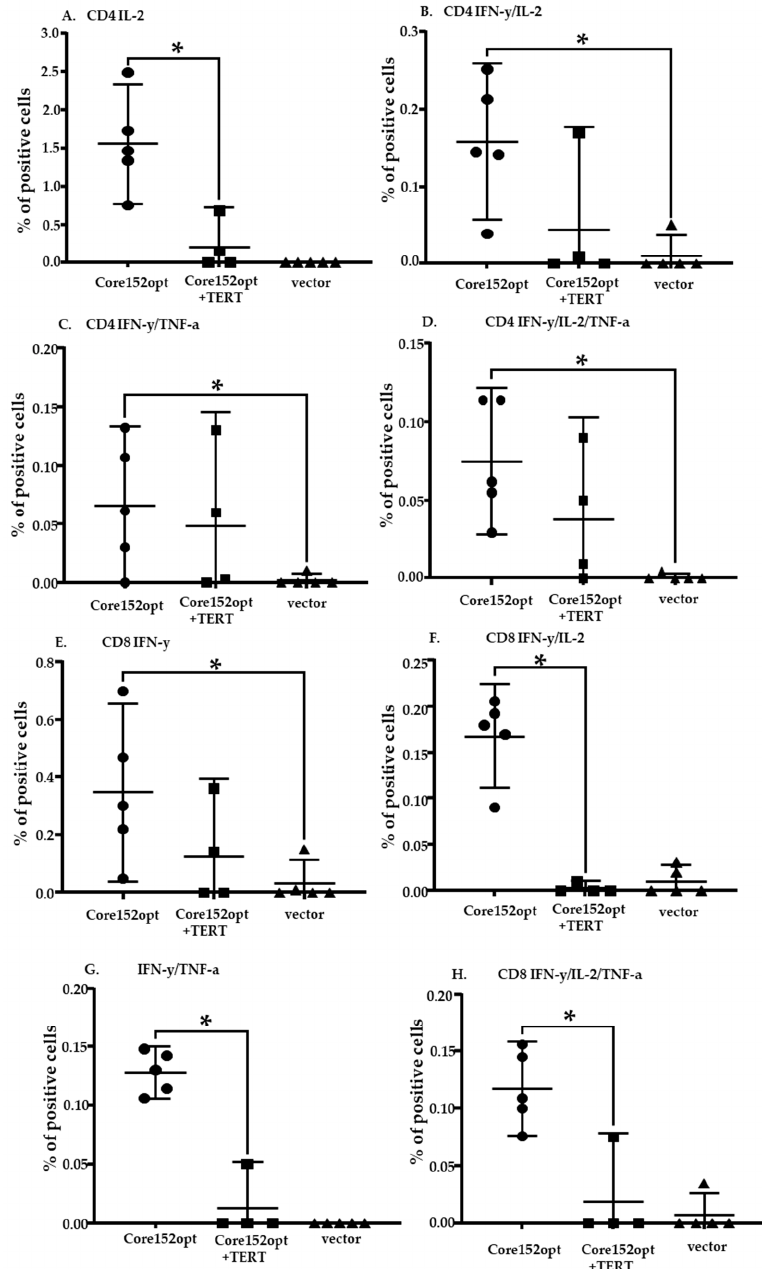
Figure 3. Cellular immune response against HCV core in mice DNA immunized with HCV Core152opt mixed with TERT compared to Core152opt alone (Series I and II, Table 1). Comparison of percent of CD4+ ( A – D ) and CD8+ ( E – H ) cells responding to stimulation with HCV core peptide pool (Table 1) by production of IL-2 ( A , E ), IFN- γ /IL-2 ( B , F ), IFN- γ /TNF- α ( C , G ), IFN- γ /IL-2/TNF- α ( D , H ). Data from is presented as mean ± 95% CI. Statistical analysis is made by Kruskal-Wallis and F-tests (Statistica Tibco, version 13.5): CD4+ T cells: IL-2: F(2,15) = 32.0616, p = 0.00000; KW-H(2,18) = 14.6055, p =